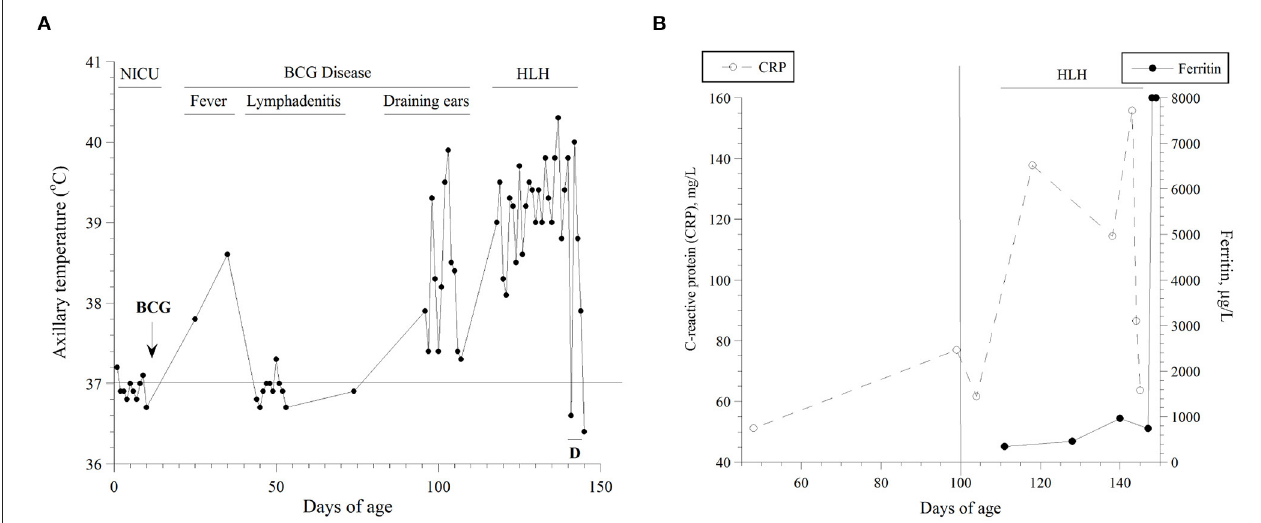
FIGURE 1 | (A) Axillary temperatures as function of age. The highest value per day is shown. The natural course of his disease is also depicted. D, dexamethasone; NICU, neonatal intensive care unit; HLH, hemophagocytic lymphohistiocytosis. He was inpatient during the highlighted periods. (B) Serum levels of C-reactive protein (CRP, mg/l) and ferritin ( µ g/l) as functions of age. Estimations of the onset (vertical line on Day 100) and duration of his HLH are depicted.